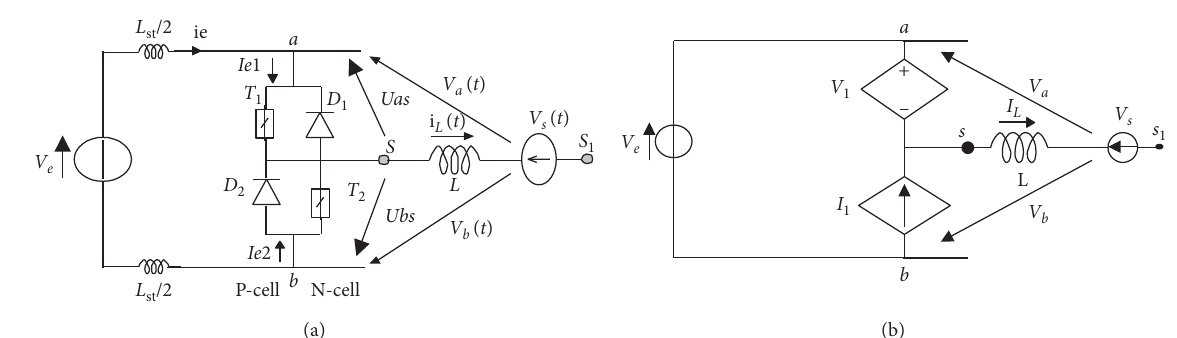
Figure 6: (a) The PWM switch. (b) The corresponding averaged